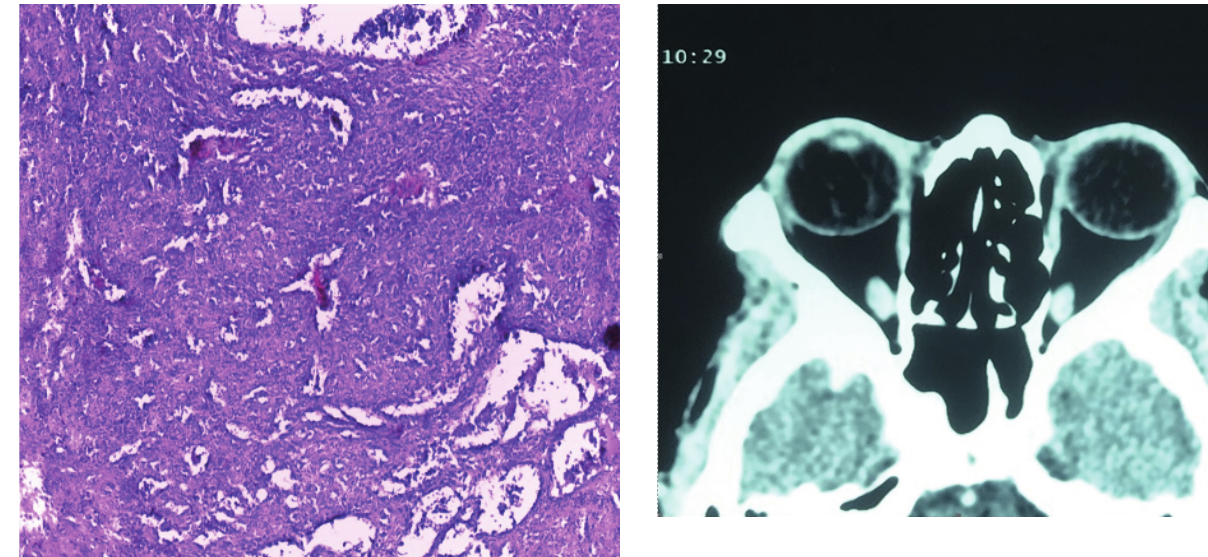
Figure 6. CT scan in axial section at 2 years of follow-up: emptiness of the sphenoid sinus cavity, fibrous remainder partitioning the sinus cavity. We can also see the septum